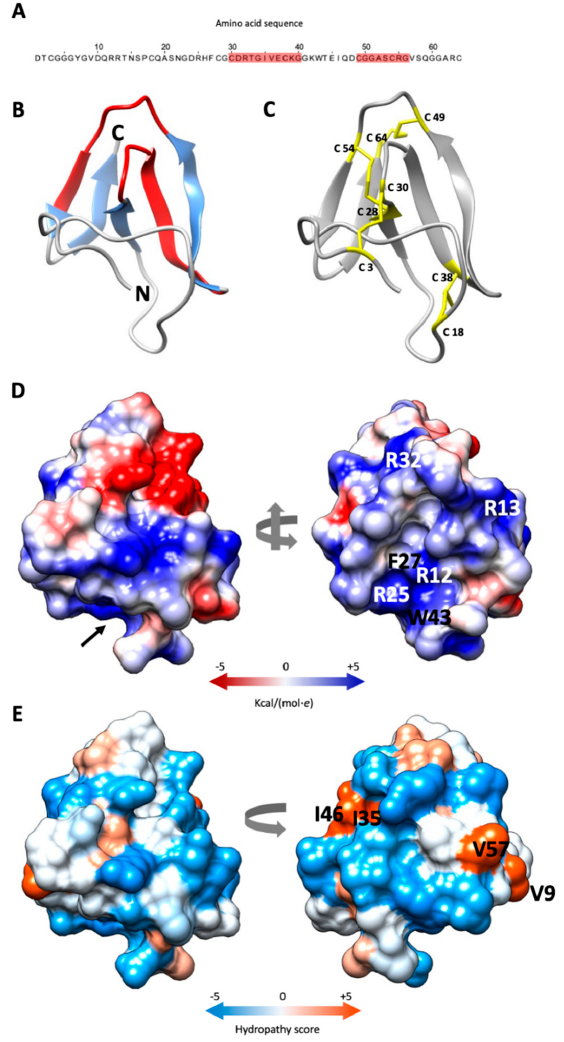
Figure 1. Predicted structure of PAFC. ( A ) Amino acid sequence (aa) of PAFC with the two predicted γ -core motifs highlighted in red. ( B ) Ribbon representation of PAFC in UCSF Chimera protein visualization and analysis software [21] depicting the structure of the β -strands (blue) and location of the two γ -cores (red), the N- and C-terminus is indicated. ( C ) Disulfide bonding of PAFC is shown with yellow sticks. ( D ) Surface representation of PAFC in two orientations colored according to electrostatic potential (blue: electropositive, red: electronegative). The model depicted on the right side visualizes the “mouth-like” cavity indicated by a black arrow in the left model. The basic aas surrounding the opening and the aa forming the funnel base are indicated. ( E ) Distribution of hydrophobic and hydrophilic patches on the surface of PAFC in two orientations colored according to the Kyte-Doolittle scale (blue: hydrophilic, orange: hydrophobic). The aas forming the hydrophobic patches are indicated in the model on the